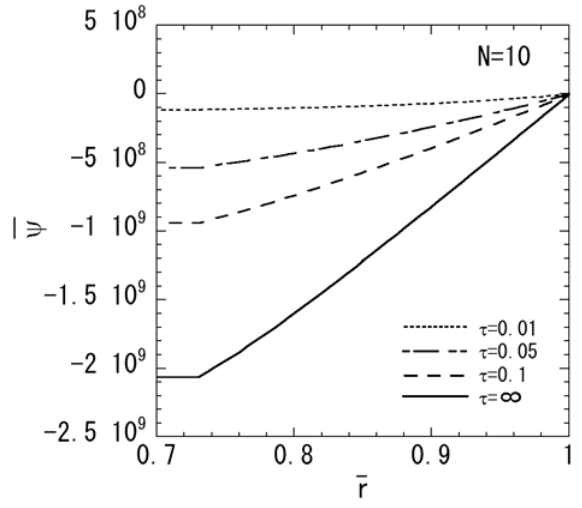
Figure 5. Variation of the magnetic potential